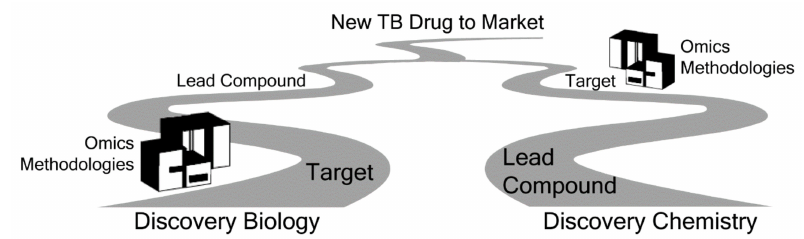
Figure 1. The application of omics tools to antimicrobial drug discovery pathways. In a discovery biology approach, omics methodologies are used early in the process to identify new targets for investigation. In a discovery chemistry setting, omics techniques are useful further down the road to identify mechanism of action of lead